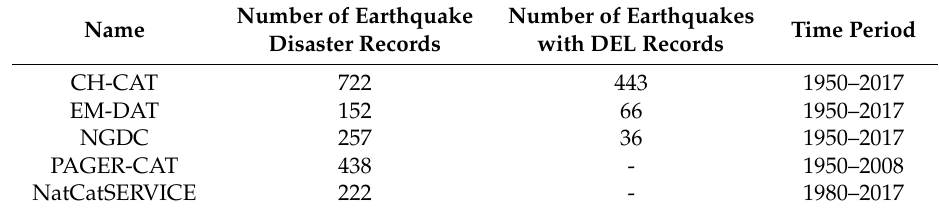
Table 3. Comparison of the total number and time scale of earthquake disasters in five databases for the mainland of China.